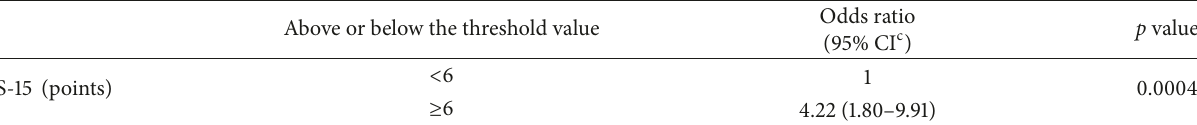
Table 3: Evaluation of odds ratio for LS a according to GDS-15 b score. Above or below the threshold value